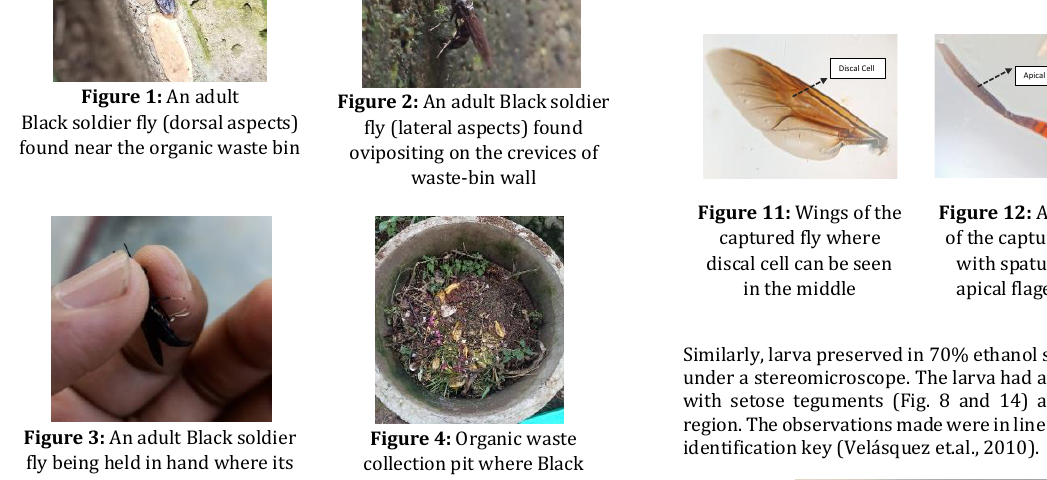
Figure 4: Organic waste collection pit where Black soldier fly and larva were recorded.